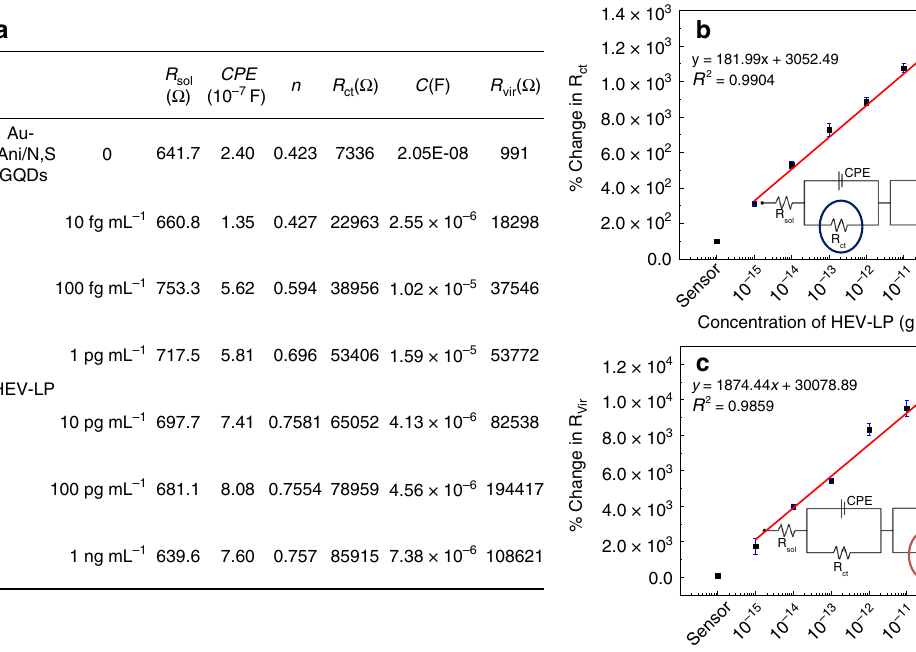
Fig. 5 Electrochemical parameters of the sensor electrode obtained from impedimetric circuit diagram: a before and after immobilization of each concentration of HEV-LP; calibration lines obtained from b R ct vs. HEV-LP concentration, and c R Vir vs. HEV-LP concentration. Circles in the insets in b and c denote the measurable component of the circuit diagram. Error bars represent the standard deviation of triple